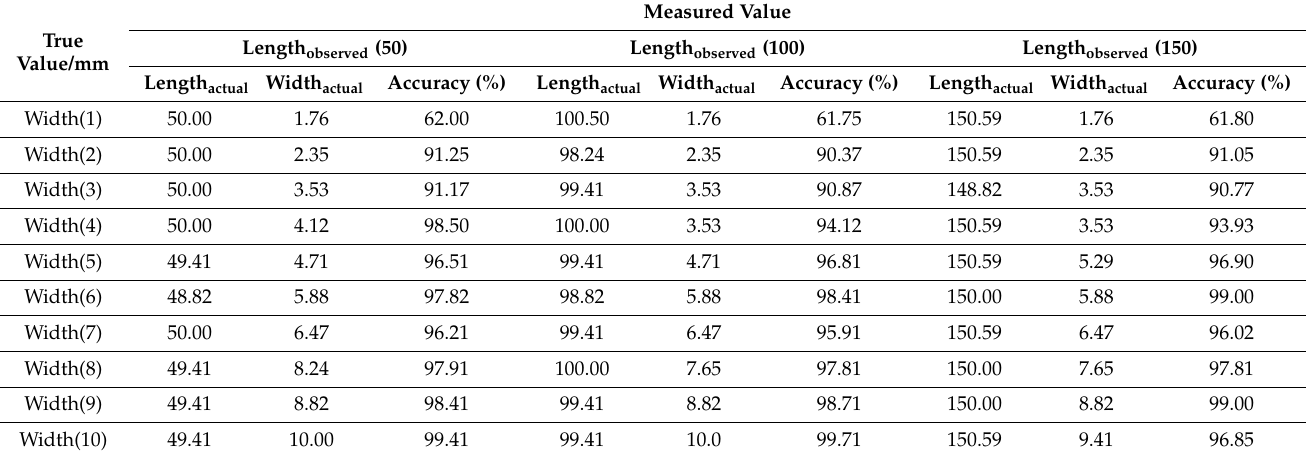
Table 1. Measured values of three sizes of mini-cracks based on laser excited